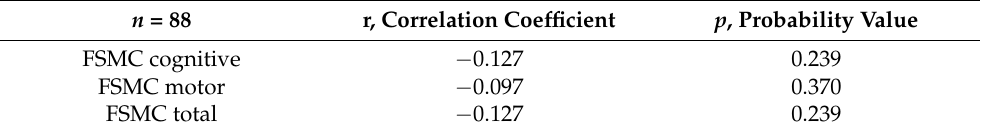
Table 8. Correlation by Spearman-Rho of adjusted NfL level (Z-score) and fatigue severity in all patients with rheumatic diseases n =